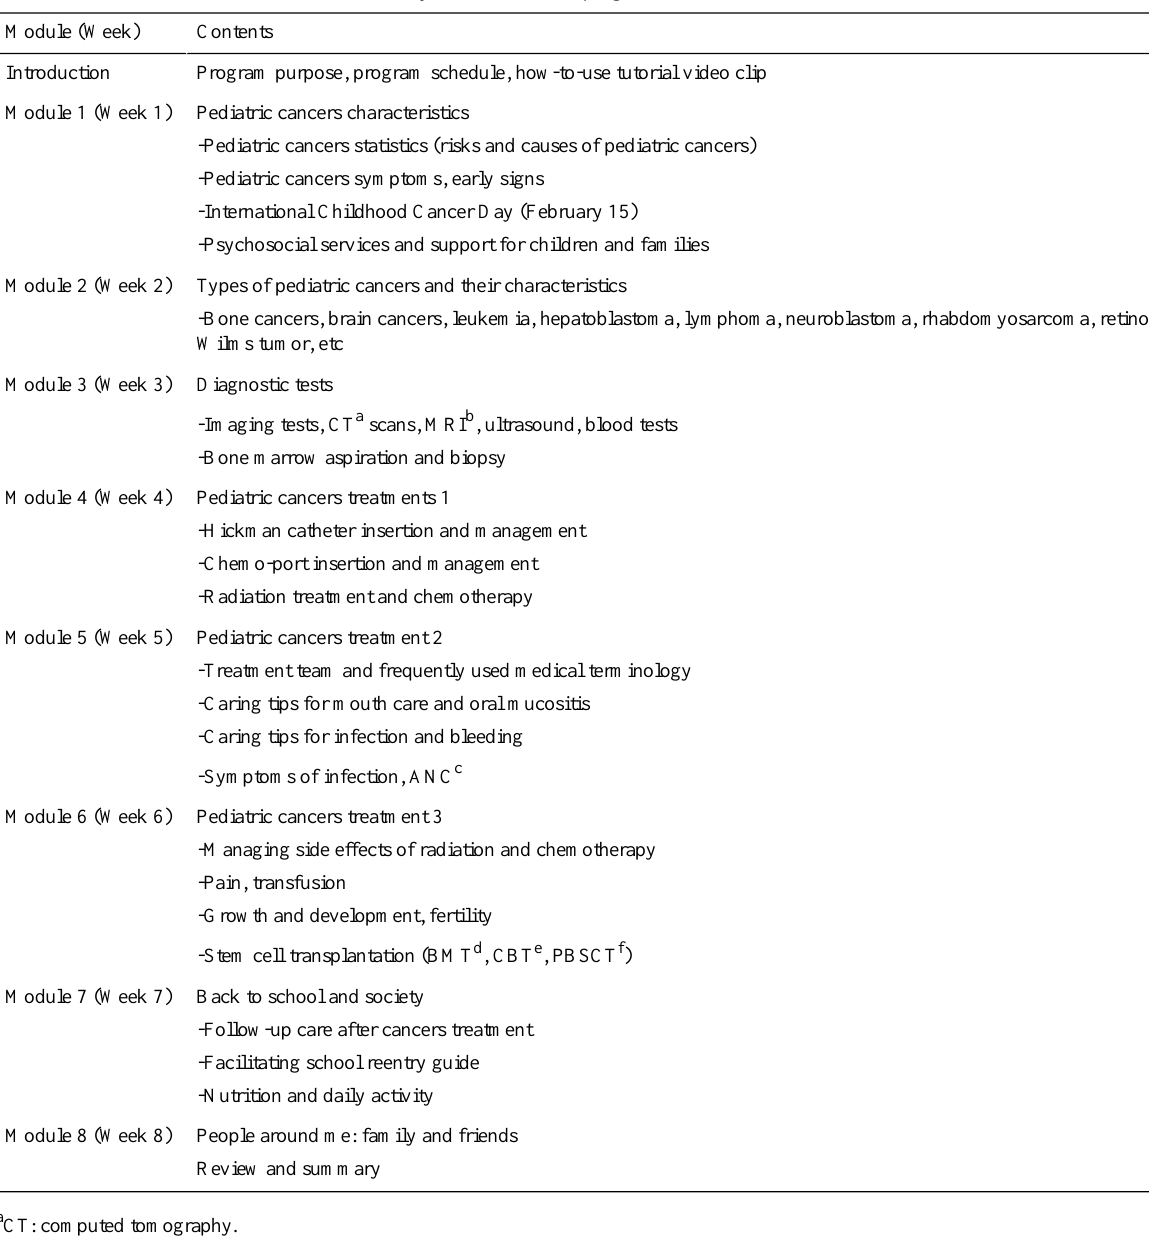
Table 3. Overview of the Facebook-based Healthy Teens for Soaam